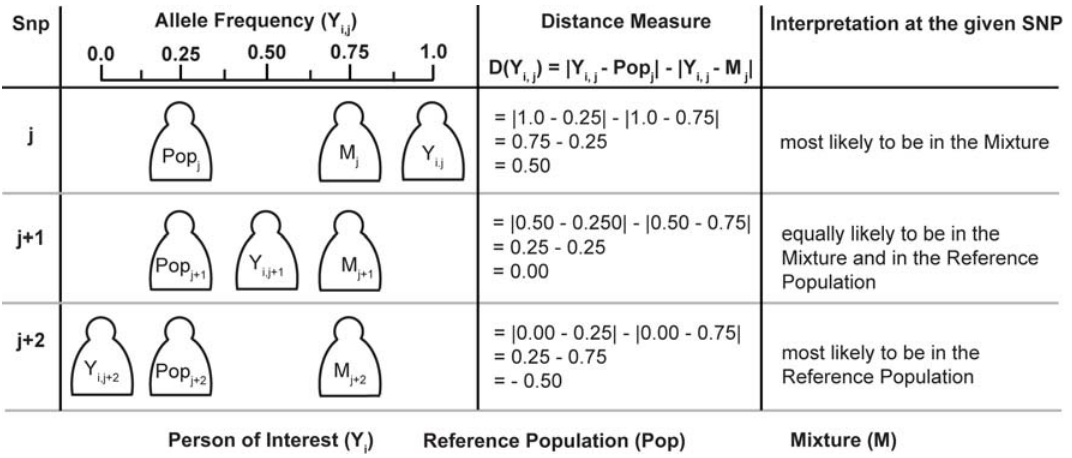
Figure 1. To give insight into the intuition behind our method, we present for a given SNP three different scenarios for the possible allele frequency of the person of interest corresponding to the genotypes AA, AB, and BB. The allele frequencies of the reference population, person of interest, and the mixture are described as M i , Y i , and Pop i respectively. We see that the distance measure is greater (and positive) when the Y i of the person of interest is closer to the M i of the mixture than to the Pop i of the reference population. Similarly, the distance measure is smaller (and negative) when the Y i of the person of interest is closer to the Pop i of the reference population than to M i of the mixture. Our test statistic is then the z-score using this distance